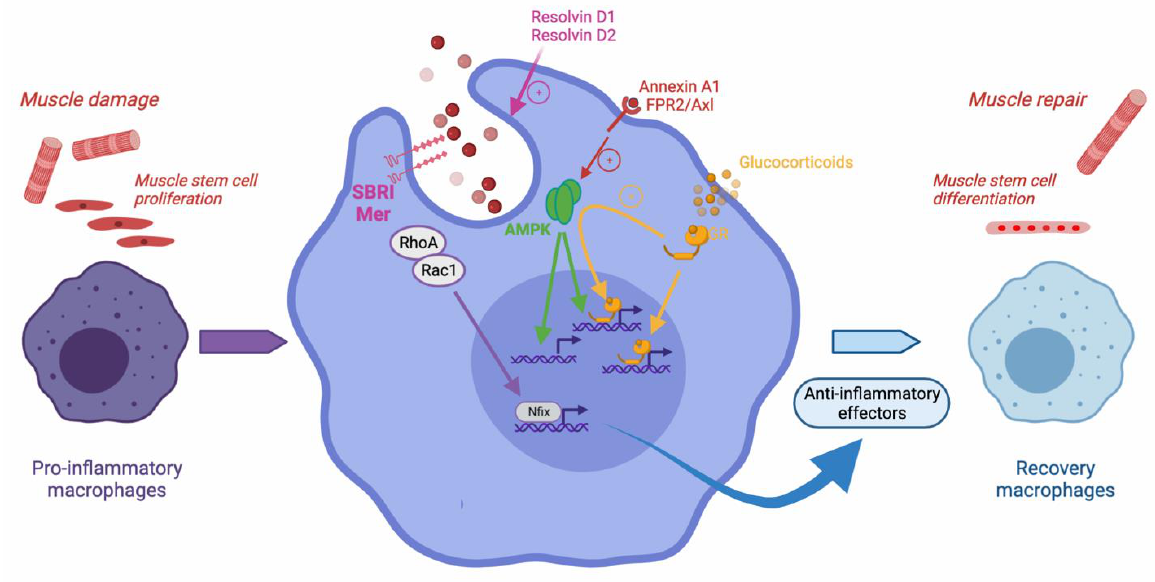
Figure 1. Efferocytosis during skeletal muscle regeneration. Upon muscle damage, pro-inflammatory monocytes enter the injured area and become pro-inflammatory macrophages that exert various properties such as stimulating the proliferation of muscle stem cells. Upon efferocytosis of muscle debris, they operate the resolution of inflammation and activate the expression of anti-inflammatory genes, and further shift into repair macrophages that stimulate myogenesis and the formation of new functional myofibers. Several molecular mechanisms have been involved in efferocytosis regulation during muscle regeneration. The scavenger receptor SBRI and Mer are required. RhoA/Rac1 inhibition leads to the expression of Nfix, a transcription factor involved in the expression of anti-inflammatory genes. The metabolic regulator AMPK is required for the efferocytosis-dependent resolution of inflammation. AMPK may be activated by the resolvin Annexin A1, through its FPR2/axl receptor. Resolvins D1 and D2 were also shown to increase efferocytosis and expedite muscle regeneration. Upon glucocorticoid stimulation, the glucocorticoid receptor activates AMPK and exerts both direct canonical and indirect non-canonical anti-inflammatory effects. The non-canonical action stimulates the expression of genes involved in phagocytosis and efferocytosis, therefore, boosting the resolution of inflammation.